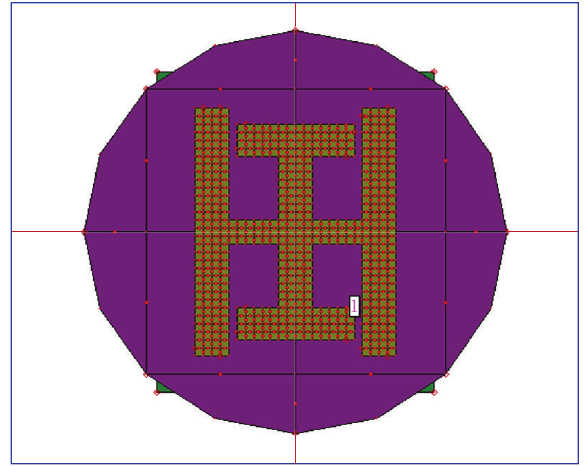
Figure 4: Geometry of proposed